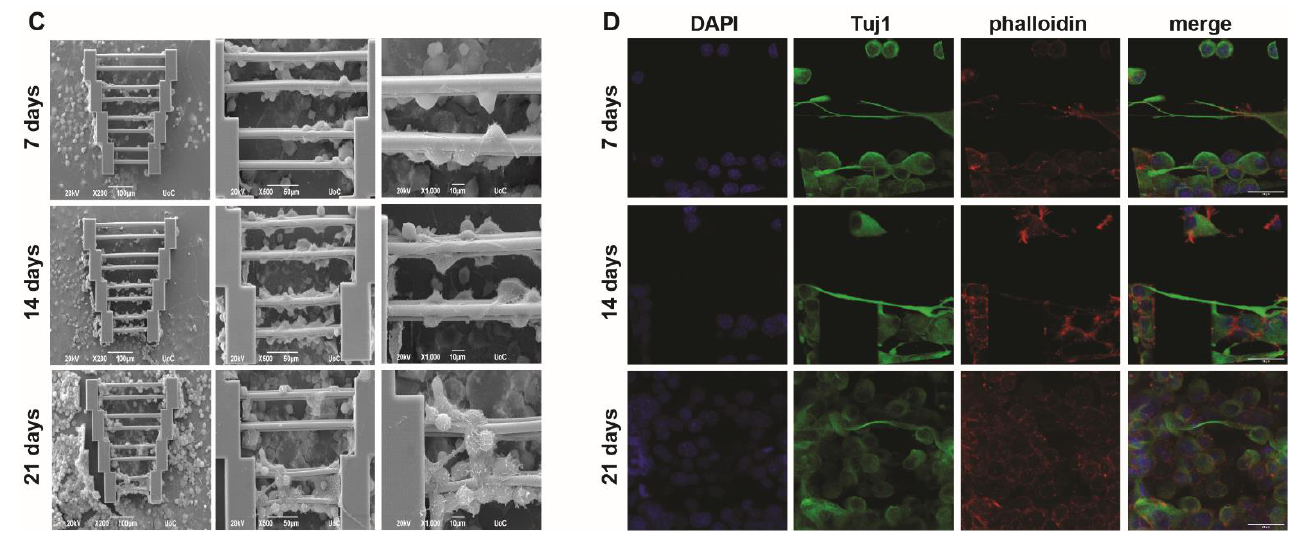
Figure 3. N2a mono-cultures. ( A , B ) Cultures on flat glass coverslips. SEM ( A ) and confocal ( B ) images show that neurites have a random orientation. In some instances, interactions of N2a cells can be observed, with random neurite orientation. ( C , D ) Cultures on scaffolds. SEM ( C ) and confocal ( D ) images show that cells that grow axons on the guidewires exhibit a selective directionality, which may or may not continue if the axons extend outside the guidewires. Scale bars in panels ( B ) and ( D ) are given in the merged images and are 30 µ